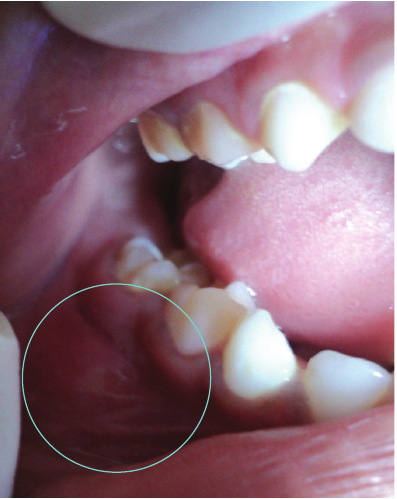
Figure 1: Intraoral appearance of the swelling of the lesion in relation to 84 and 85.